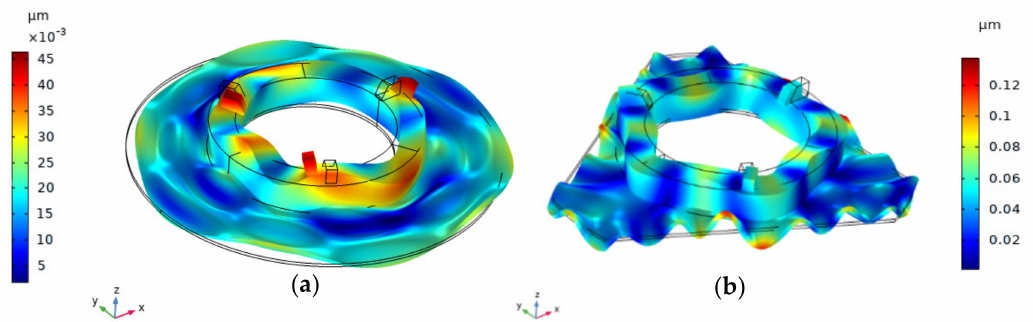
Figure 6. Modal shapes of vibration of the unimorph actuator: ( a ) with disc-shaped flange (94.8 kHz); ( b ) with triangle-shaped flange (95.3 kHz).